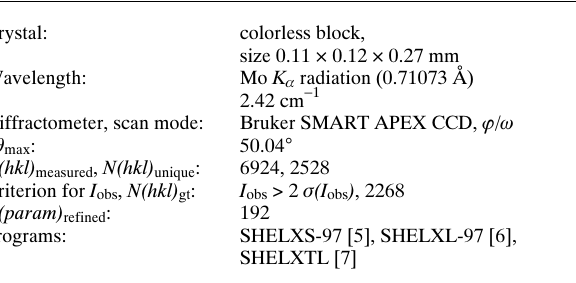
Table 1. Data collection and handling.